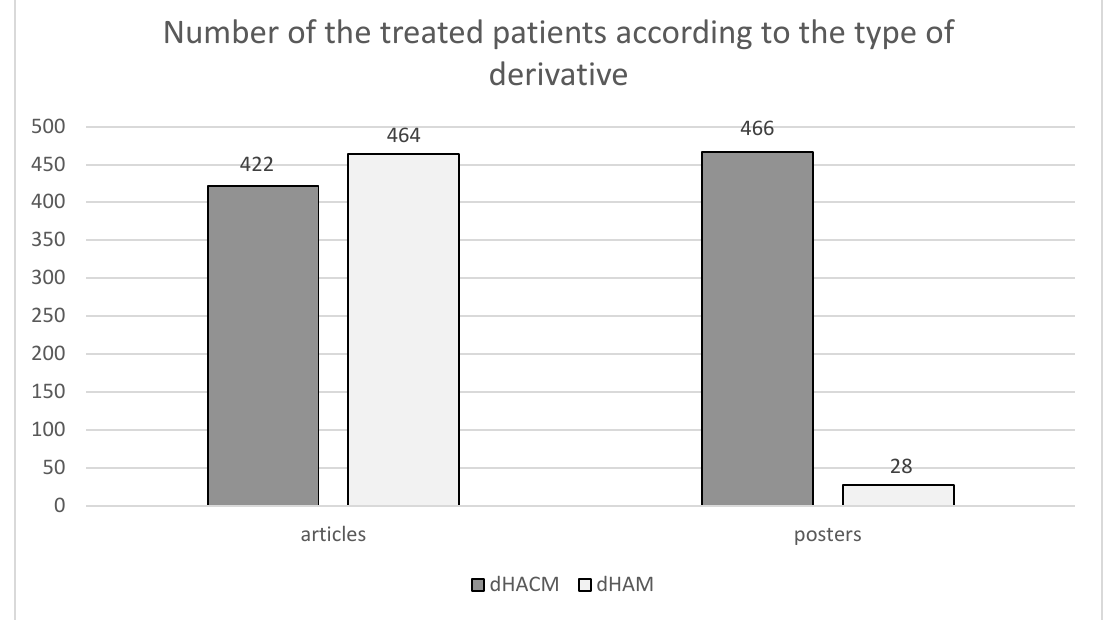
Figure 7. Shows the division of patients according to applied derivates (HAM/HACM). In the selected set of articles, 422 patients were given HACM and 464 patients were given dHAM. In the selected set of posters, dHACM was administered to 466 patients and dHAM was administered to 28 patients [1–99].